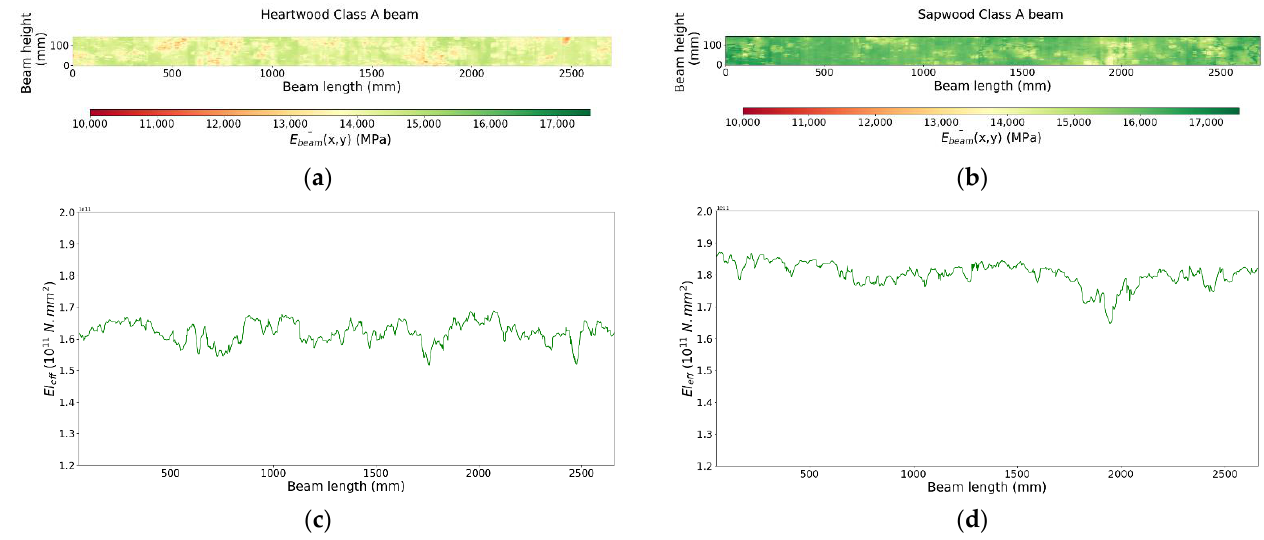
Figure 10. Random beams: ( a ) heartwood E beam ( x , y ) , ( b ) sapwood E beam ( x , y ) , ( c ) heartwood EIeff(x) profile, ( d ) sapwood EIeff(x) profile.